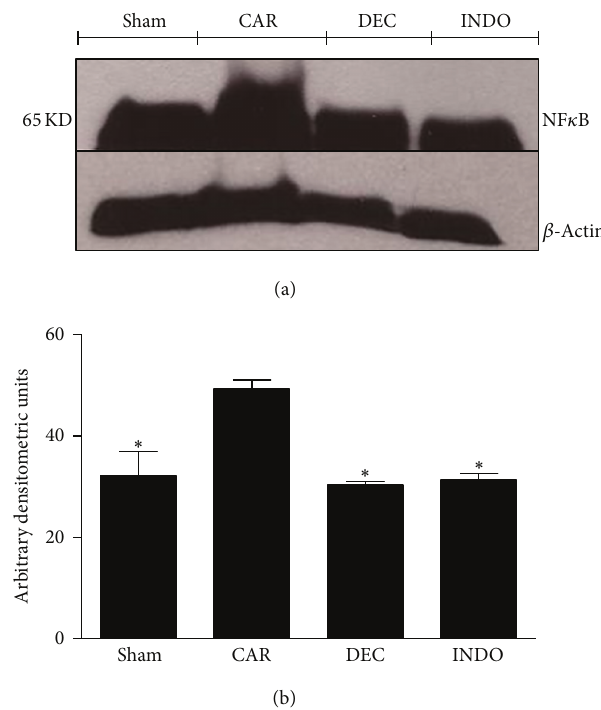
Figure12:EffectsofDEConcarrageenan-inducedNF 𝜅 Bexpression in the lung. Basal expression of NF 𝜅 B was detected in lung samples obtained from the sham group, whereas NF 𝜅 B levels were signif- icantly increased in lung tissue of animals 4 hours after injection of carrageenan. Treatment with DEC and INDO reduced NF 𝜅 B expression in comparison to the CAR group. (a) Representative blot oflysatesobtainedfrompool4animalspergroup;(b)dataexpressed as mean ± S.E.M. of 3 replications for each group; ∗ 𝑃 < 0.05 versus